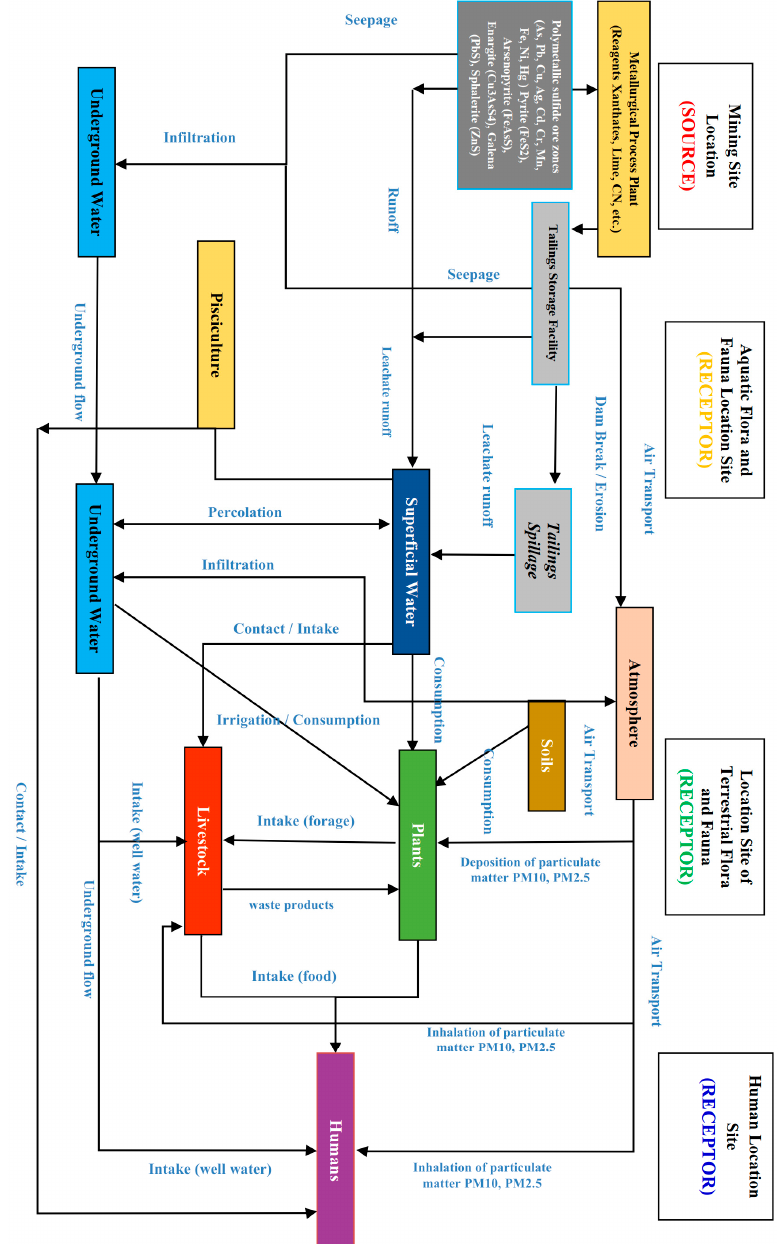
Figure 3. Conceptual Model of Contamination from Mining Tailings Spill (Modified from [36]).